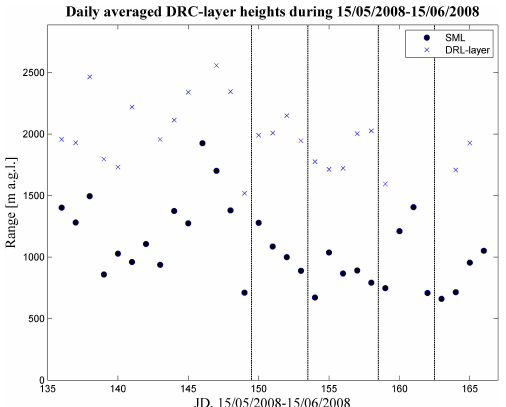
Fig. 4. Boundary Layer (residual and convective) height and Sur- face Mixed Layer height from 15 May 2008 at Mace Head. The y-axis is meters a.g.l. where ground level is approximately 15m a.s.l. The x-axis is Julian Day (JD). The vertical lines separate the different air masses: from left to right, these correspond to cP , cmP , mP , mT , mA ,